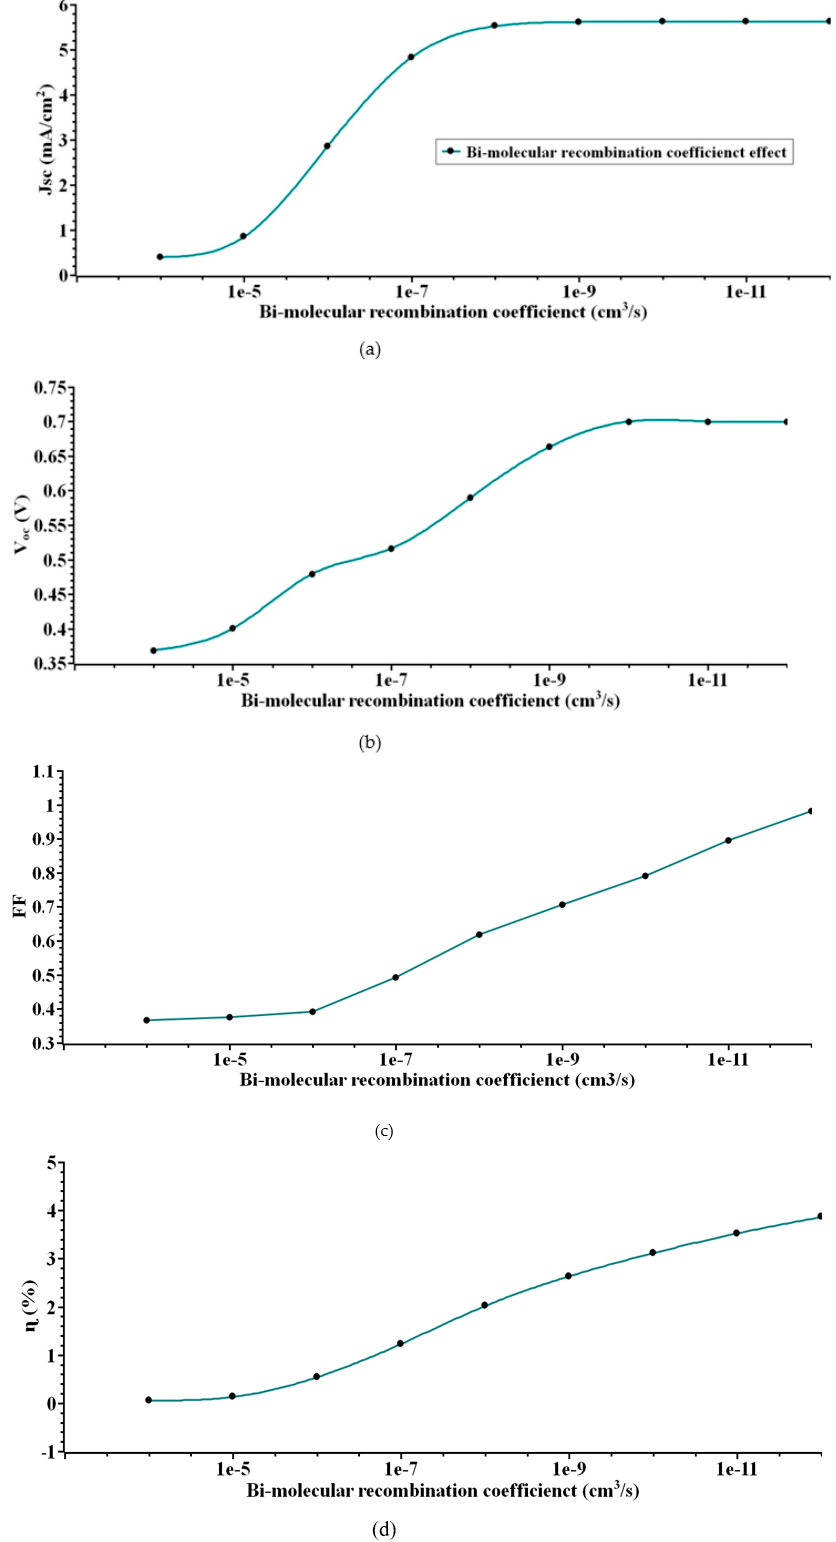
Figure 7. ( a ) J sc ( b ) V oc ( c ) FF ( d ) η . Illustrates the output extracted for various bi-molecular recombi- nation coefficients.